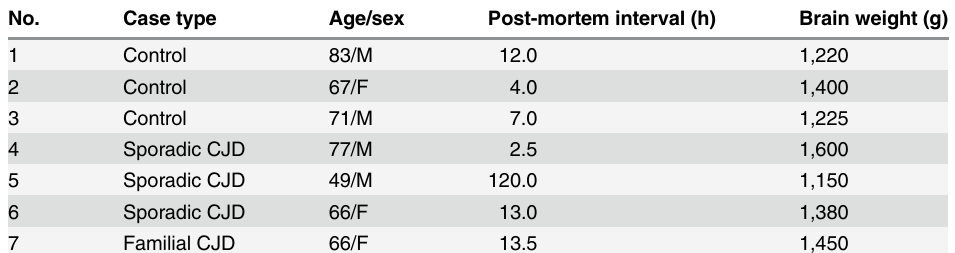
Table 1. Demographic details of post-mortem brain specimens from controls and Creutzfeldt-Jakob disease patients. No.